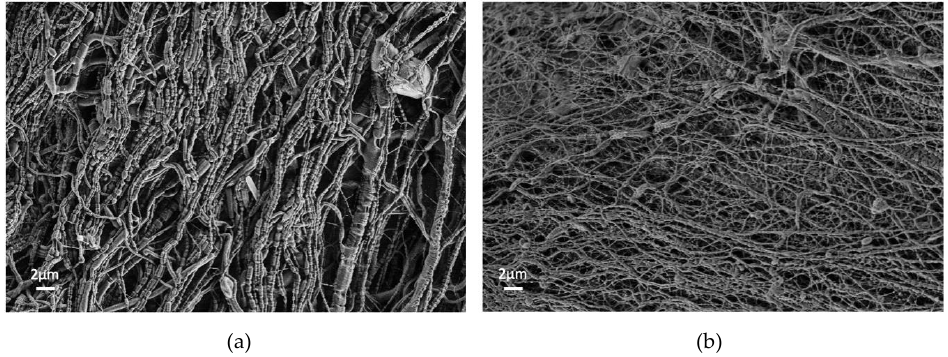
Figure 5. SEM images electrospun core-shell NFs samples collected from jussara pulp incorporation